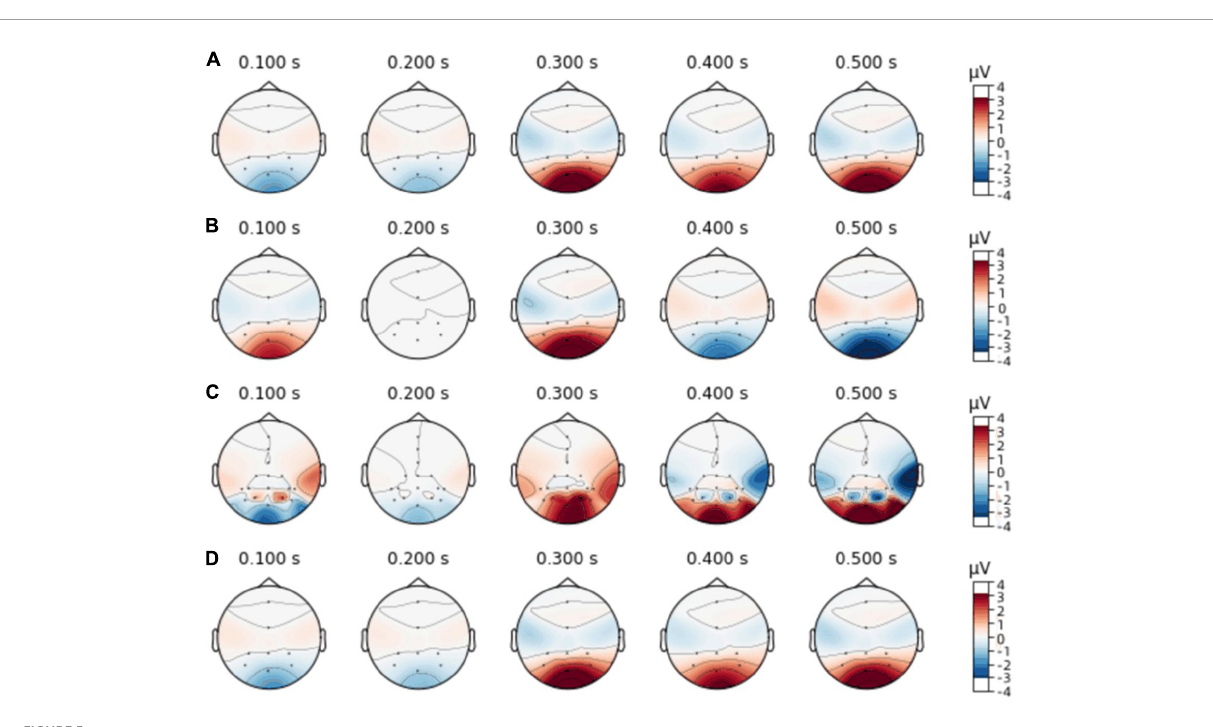
two-person centralized serial data fusion. It can be seen from Figures 4 , 5 that this method is